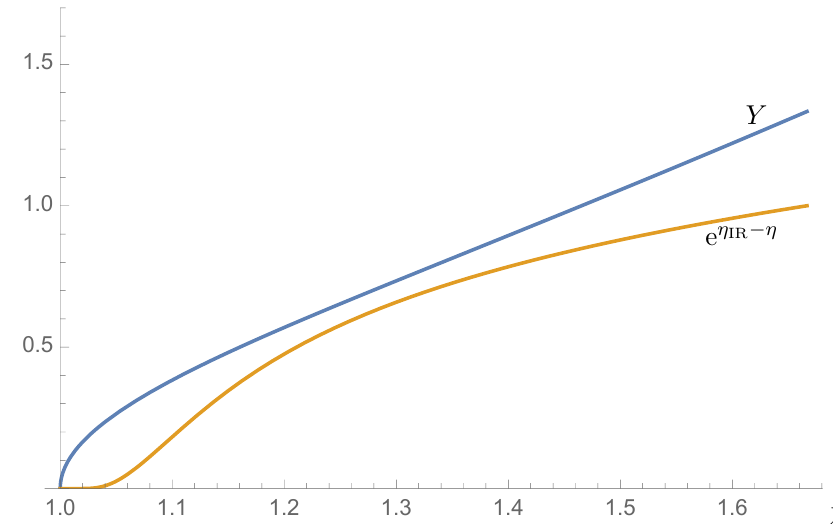
Figure 5 . The supergravity solution for the scalar (cid:12)elds Y and (cid:17) using X as the radial